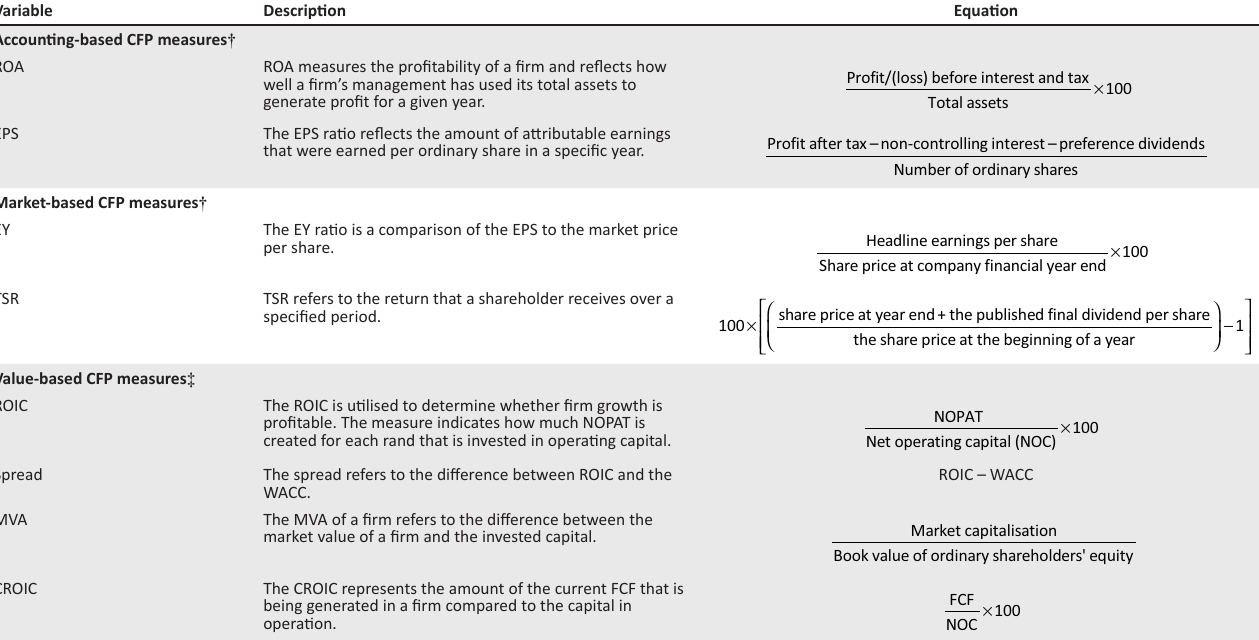
TABLE 2: Measurement of the selected corporate financial performance